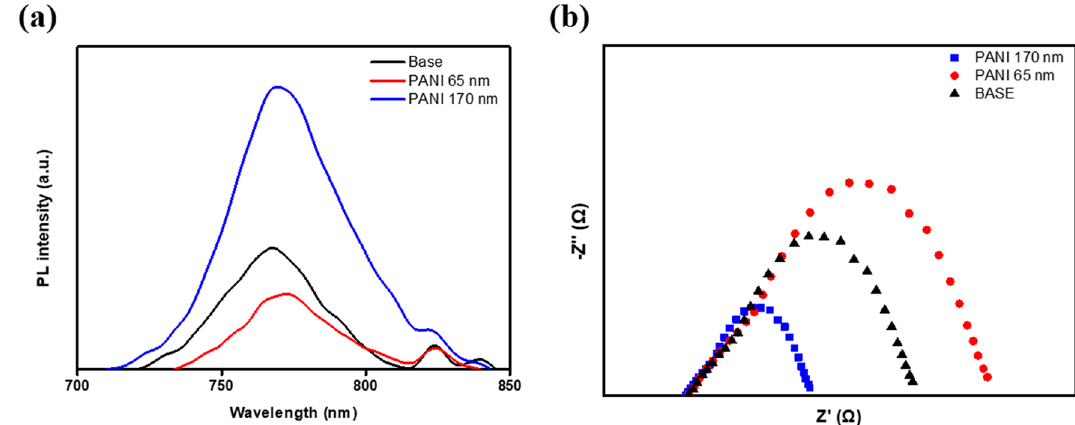
Figure 6. ( a ) The PL intensity and ( b ) the impedance of the perovskite solar cell with the